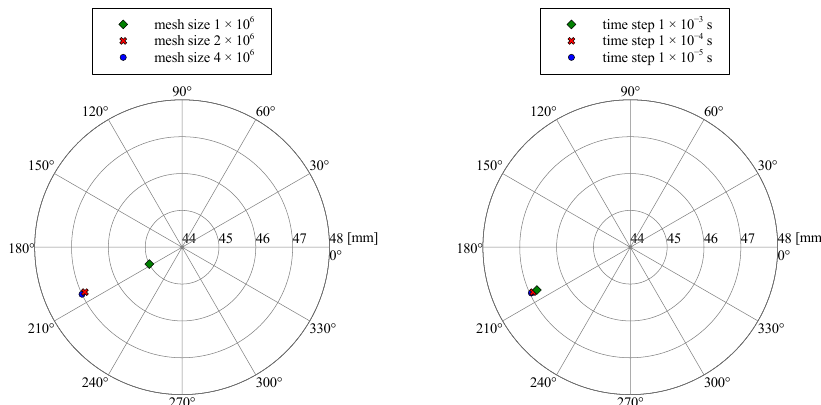
Figure 20. Vortex position at N = 2250 rpm and Qm = 0.33 m/s. ( Left ) Mesh sensitivity analysis; ( right ) time step sensitivity analysis at mesh size 2 × 10 6